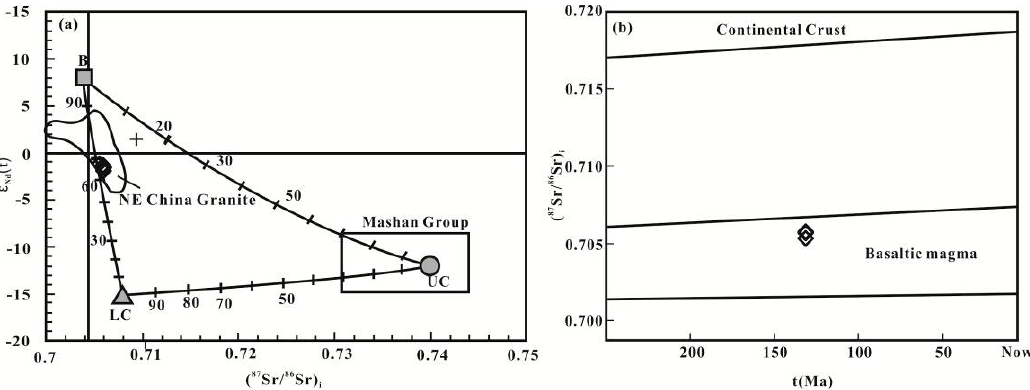
Figure 9. ε Nd ( t ) vs. ( 87 Sr/ 86 Sr) i ( a ) and ( 87 Sr/ 86 Sr) i vs. t ( b ) for the MG from the Wulandele Mo deposit. The field for NE China Granite is from [23]. The calculated parameters of Nd (ppm), ε Nd ( t ), Sr (ppm), and ( 87 Sr/ 86 Sr) i are 15, +8, 200, and 0.704 for basalt; 30, − 12, 250, and 0.740 for upper continental crust (UC); 20, − 15, 230, 0.708 for lower continental crust (LC). All end-number data derive from [23].